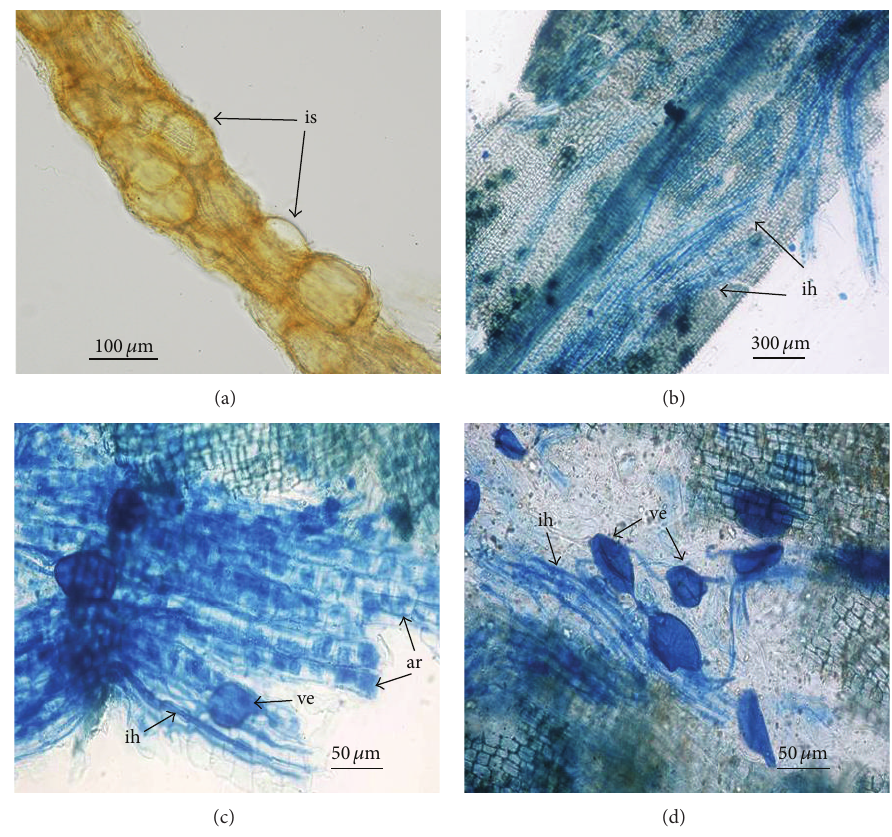
Figure 1: Intraradical spores (is), intercellular hyphae (ih), arbuscules (ar), and vesicles (ve) structures were observed in citrus roots. (a) Intraradical spores in citrus root, bar = 100 𝜇 m; (b) AM colonization citrus root, bar = 300 𝜇 m; (c) intercellular hyphae, arbuscules, and vesicles in citrus root, bar = 50 𝜇 m; (d) intercellular hyphae and vesicles in citrus root, bar = 50 𝜇